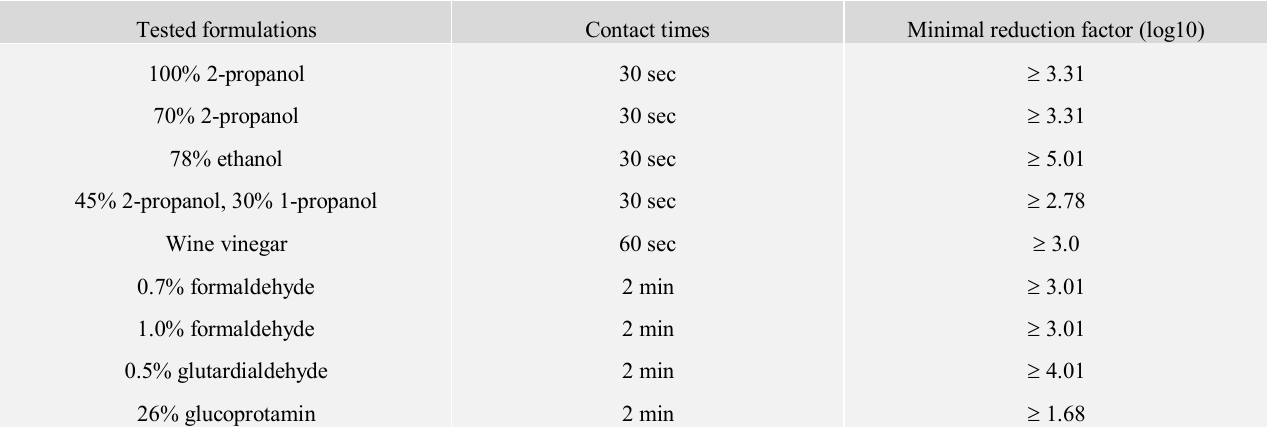
Table 3. Virucidal activity on SARS-CoV of different hand-rub formulations and surfaces disinfectants thanks to suspension tests